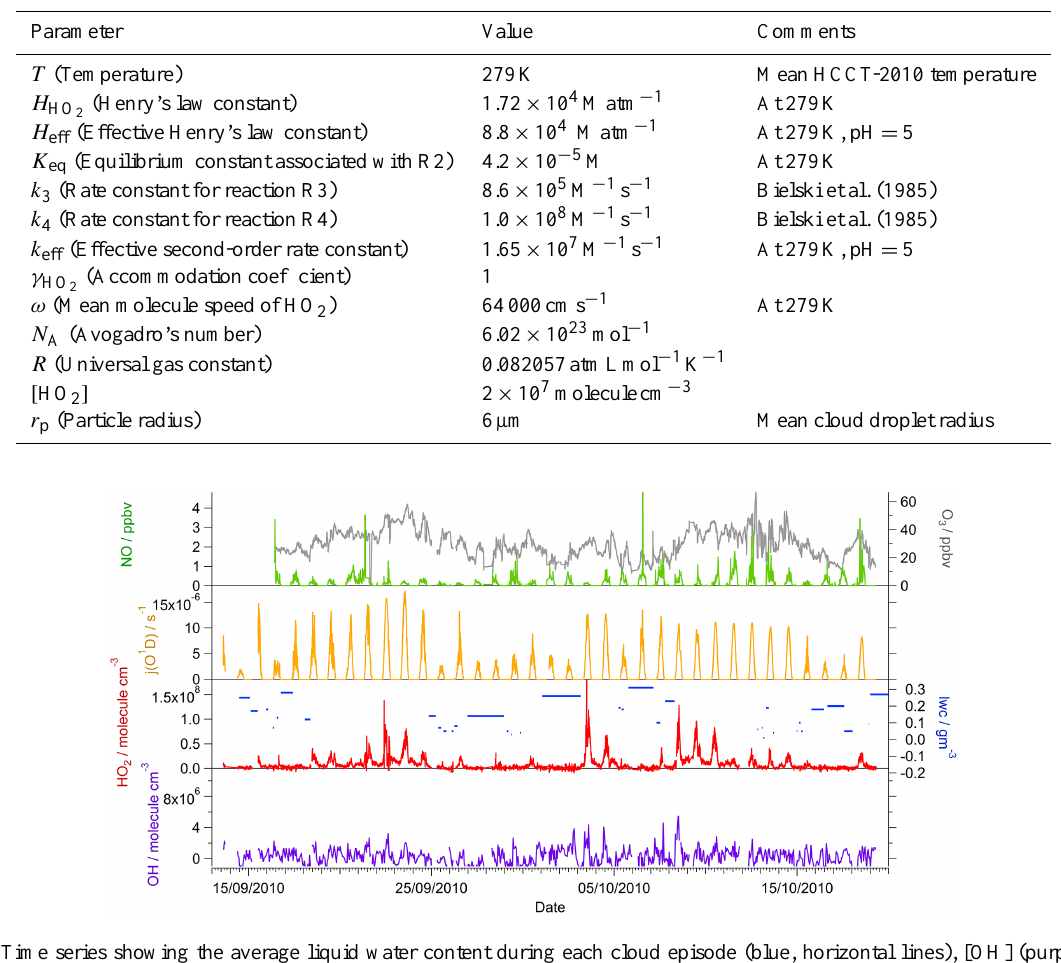
Table 2. The values used for the calculation of the theoretical uptake coefficient, black triangles, Fig. 5b, as a function of pH; values given at pH = 5 here.